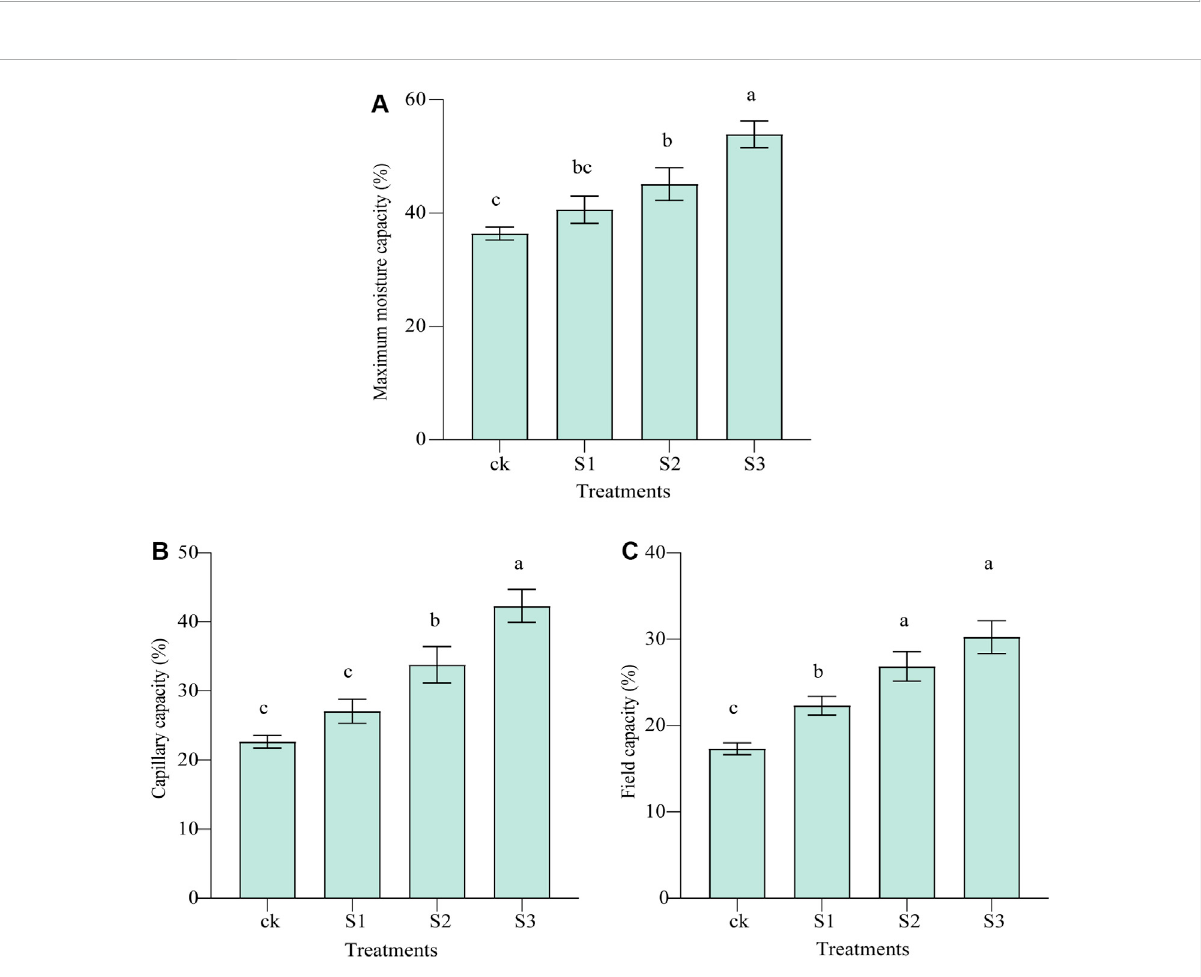
FIGURE 2 Effect of co-application of biochar and bio-organic fertilizers (BOF) on WHC of soil. (A) maximum moisture capacity, (B) capillary capacity, and (C) fi eld capacity.